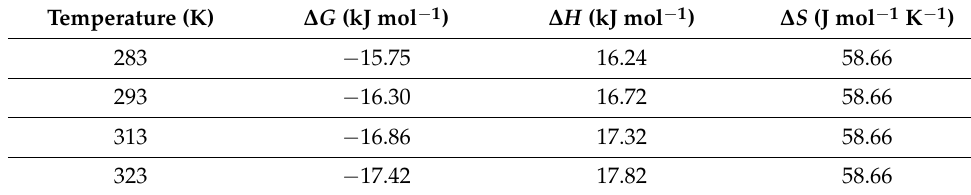
Table 3. Thermodynamic parameters of adsorption of Cd (II) ion onto AC. Temperature